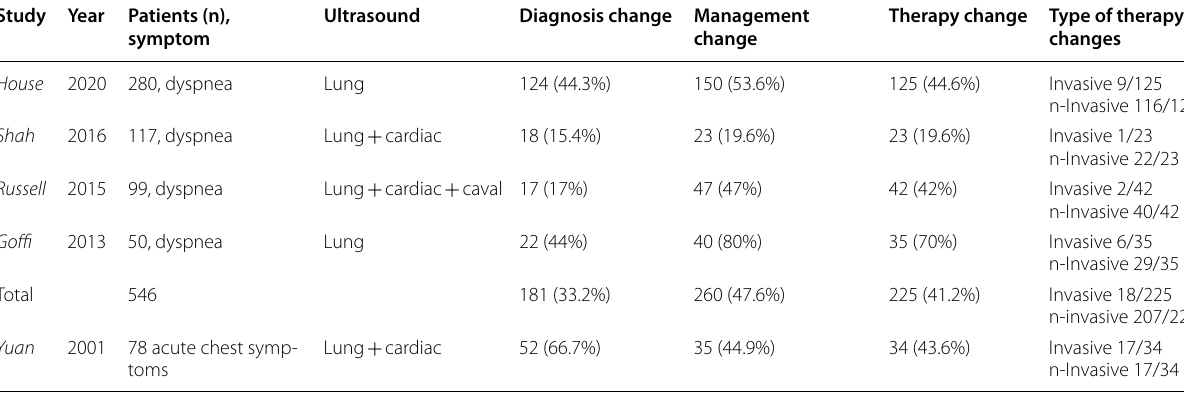
TOTAL referred to the compilation of studies published after April 2008; ED emergency department